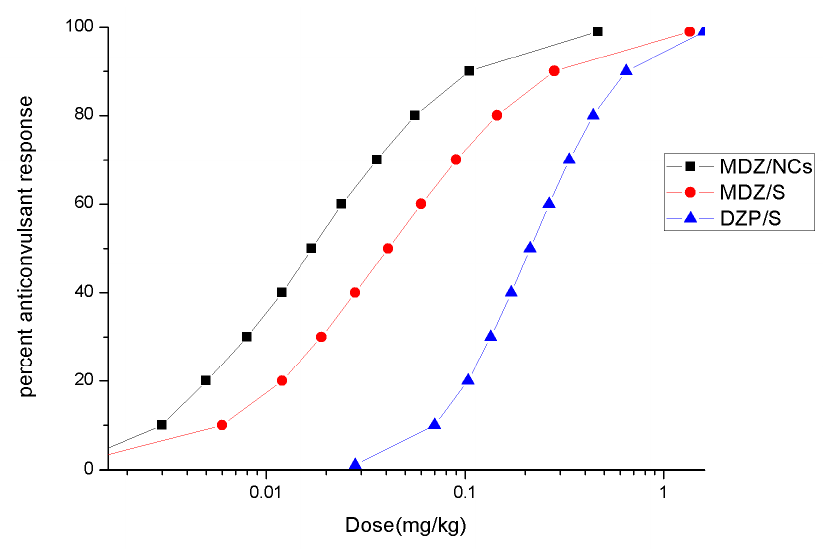
Figure 8. Fitted dose–effect curves calculated from the results of the probit analysis for anticonvulsant effects.